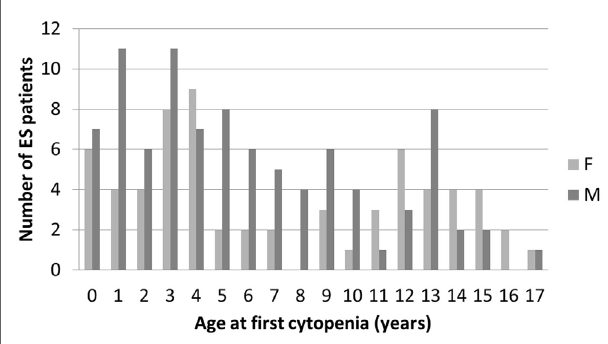
FigUre 1 | age and gender distribution at initial diagnosis of the first cytopenia in 156 children with es